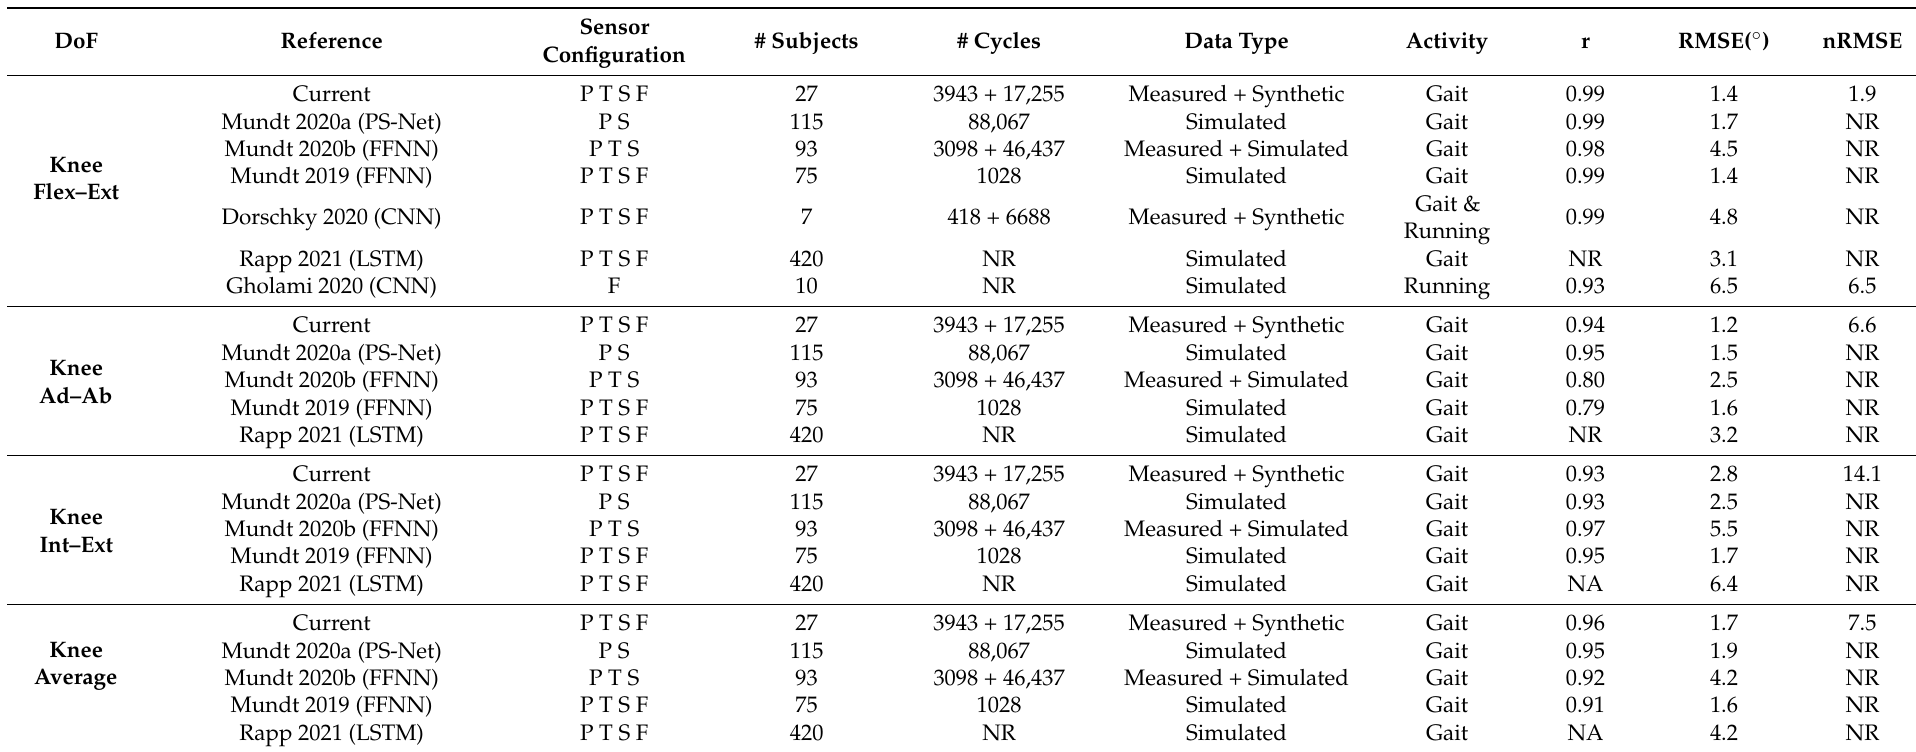
Table 5. Reported prediction accuracy compared with previous studies for knee kinematics. Sensor configurations included pelvis (P), thigh (T), shank (S), and foot (F). Synthetic data were data generated by augmented kinematics data, while simulated data were generated by existing motion capture